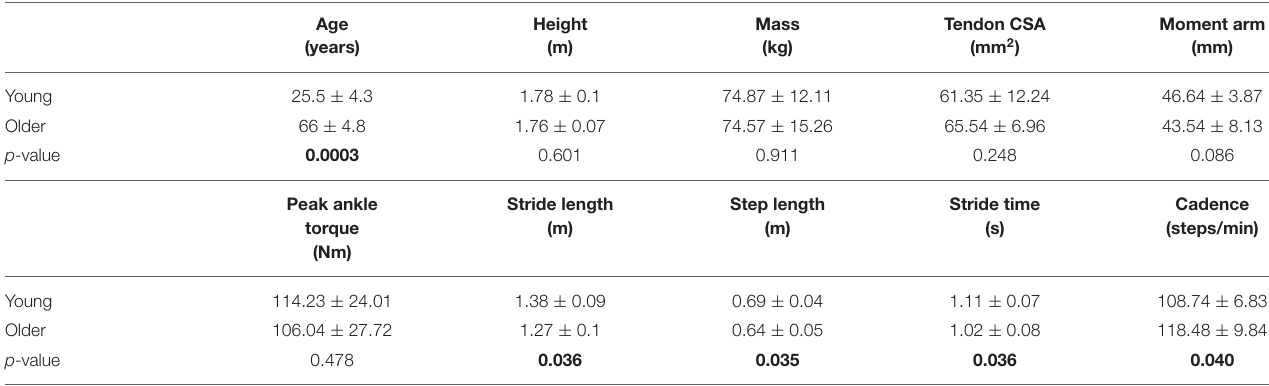
TABLE 1 | Subject characteristics (mean ± standard deviation).